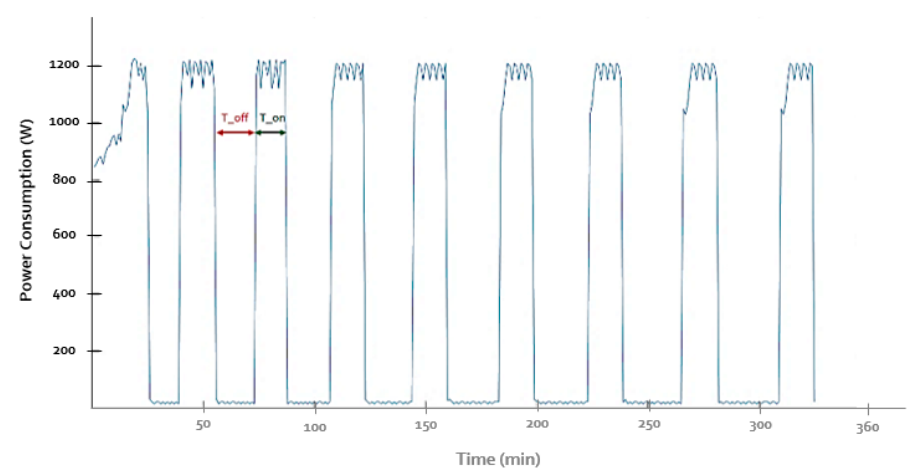
Figure 10. HVAC consumption—indoor temperature correlation.